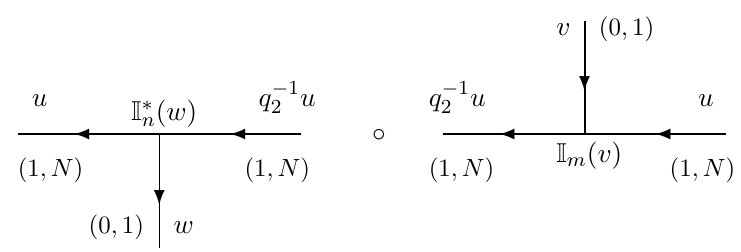
Figure 1 . Composition ◦ of the vector intertwiner and the dual vector intertwiner. Contrary to the Fock intertwiner, the level (1 , N ) of the horizontal Fock space is kept intact and the shift of the spectral parameter u is independent of the spectral parameters v, w of the vertical